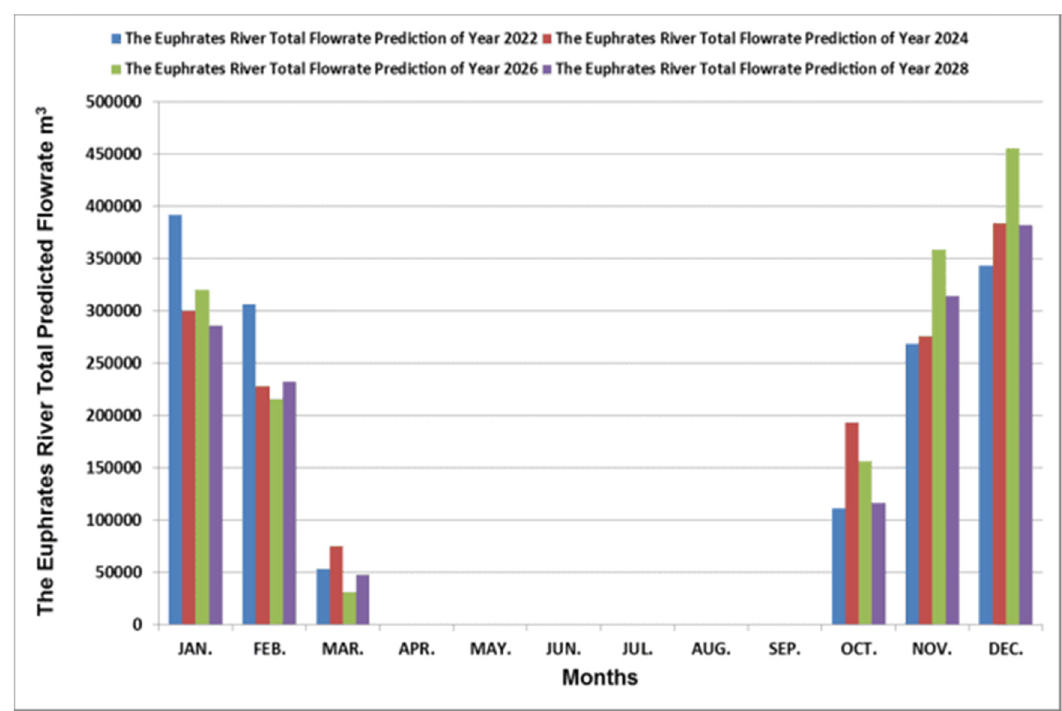
Figure 9: The total future predicted biennial fl owrates of the Euphrates